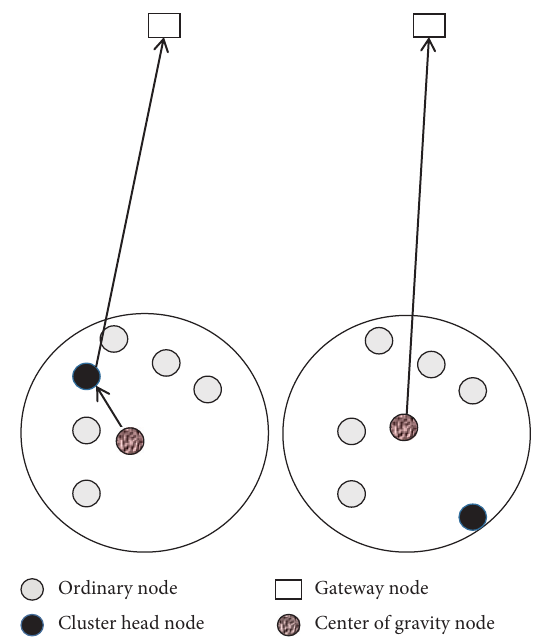
Figure 4: Coordination diagram of barycenter node and cluster head.